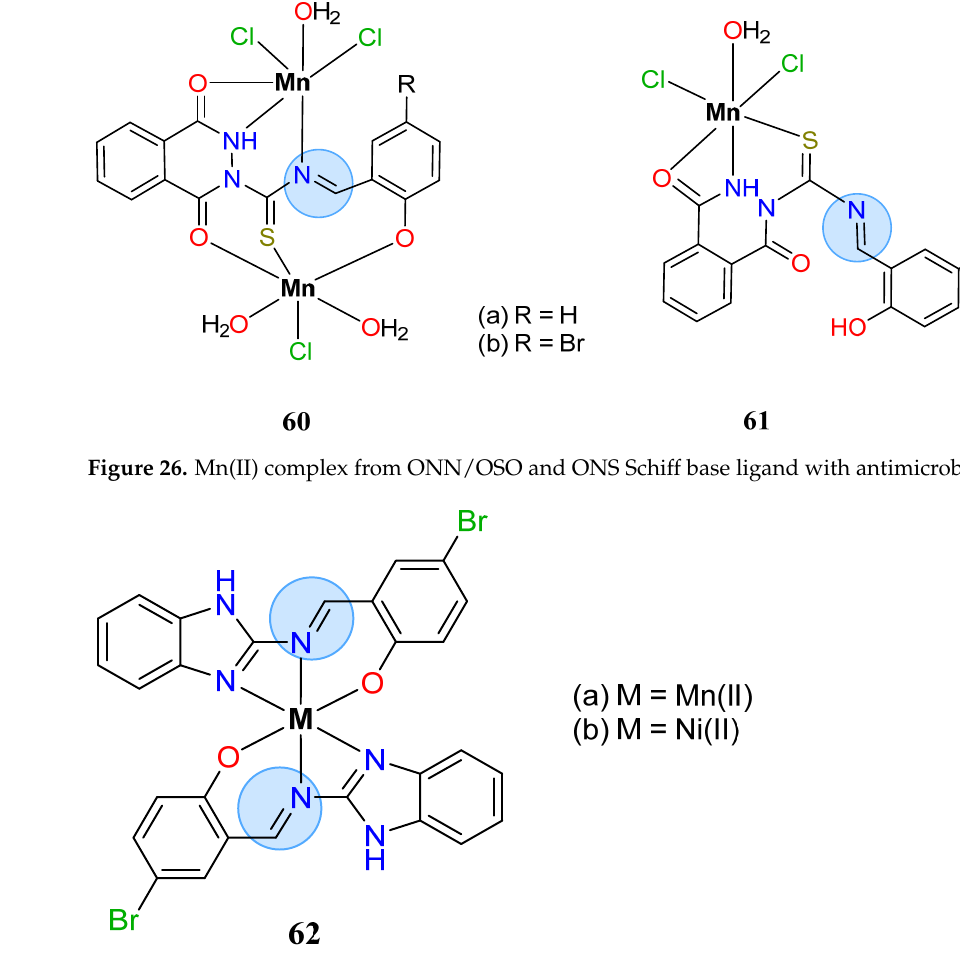
Figure 27. Mn(II) and Ni(II) complexes from tridentate Schiff base ligand (NNO) with antifungal activity. Zhang and co-workers synthesised an SB ligand and its manganese and copper com- plexes (Figure 28) to test the antimicrobial activity against the Gram-negative bacteria